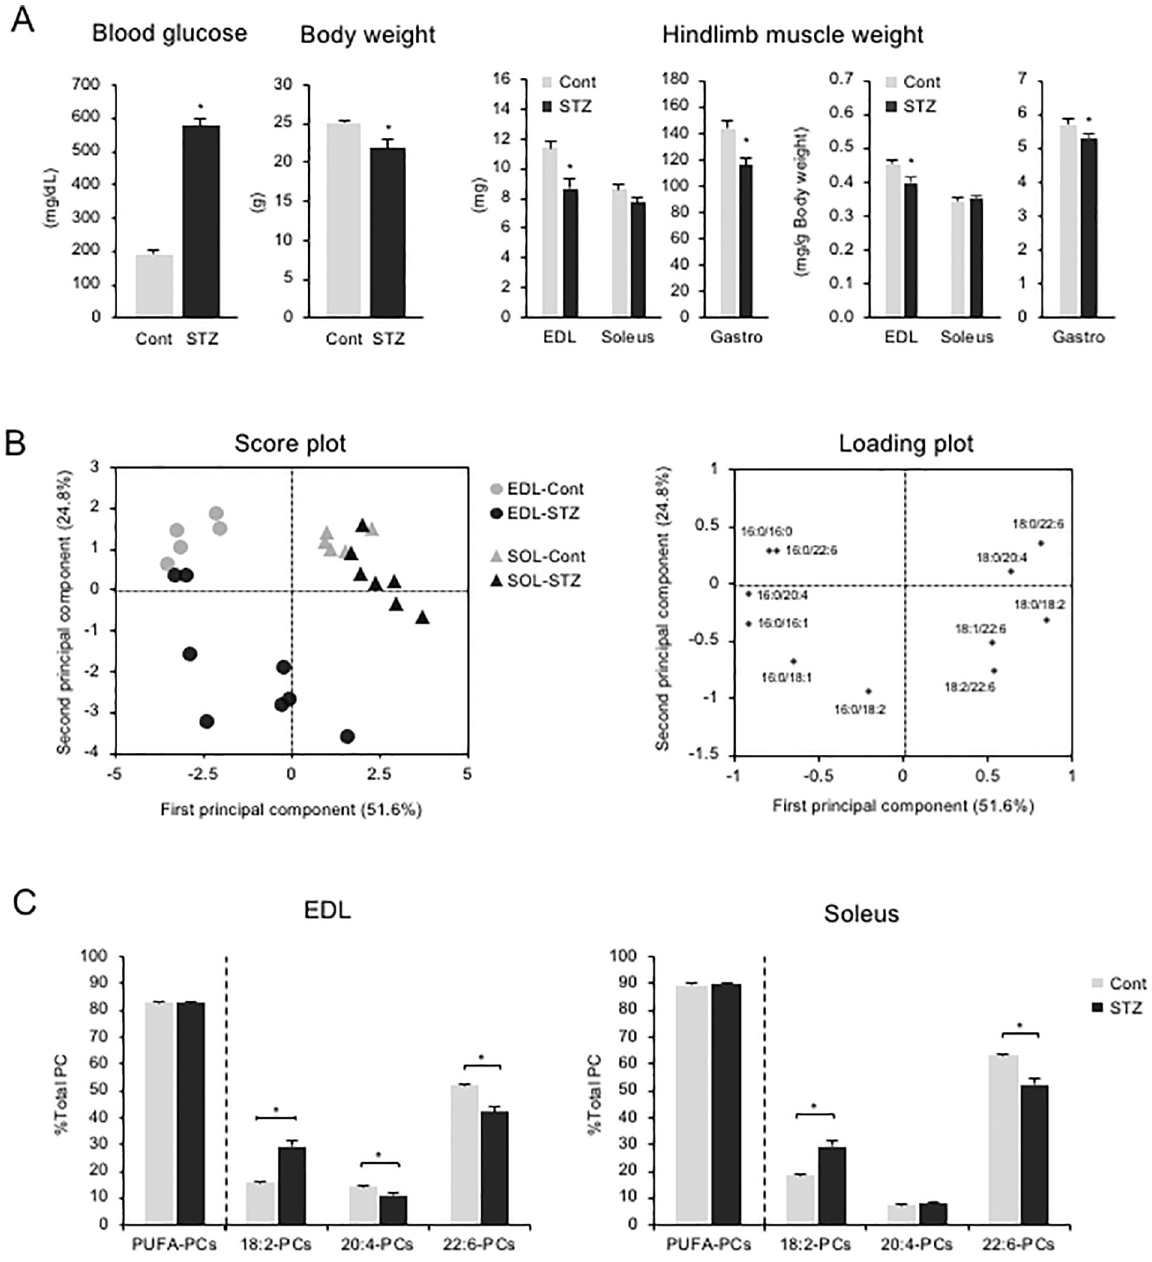
Fig 2. Effects of insulin on skeletal muscle PC profiles. (A) Blood glucose levels, body weight, and hindlimb muscle weights at dissection of control (Cont) and STZ-injected (STZ) mice. (B) Score plots (left) and loading plots (right) of PCA for measured PC species in EDL and soleus from Cont and STZ mice. Proportions of each PC group to total PC sorted by acyl-chains at sn-2 position. Values represent mean ± SE (n = 5–8); � P < 0.05.